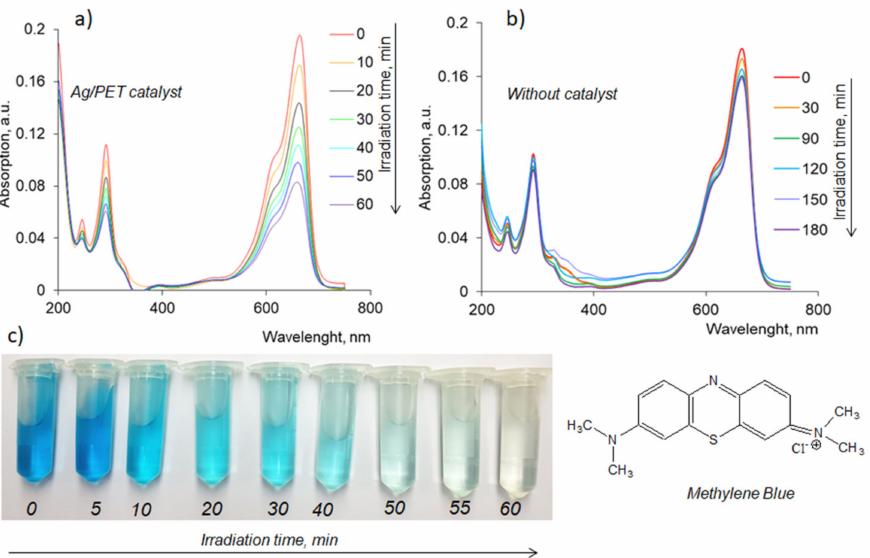
Figure 3. Typical absorption spectra for the decomposition reaction of methylene blue (MB) (0.5 mg/L) in the presence of 2 × 2 cm Ag/Polyethylene terephthalate (Ag/PET) composite mem- brane ( a ) and without any catalyst ( b ). Visual observation of color change from blue to colorless indicating the degradation of MB (0.1 mg/L) by the composite catalyst at different time intervals ( c